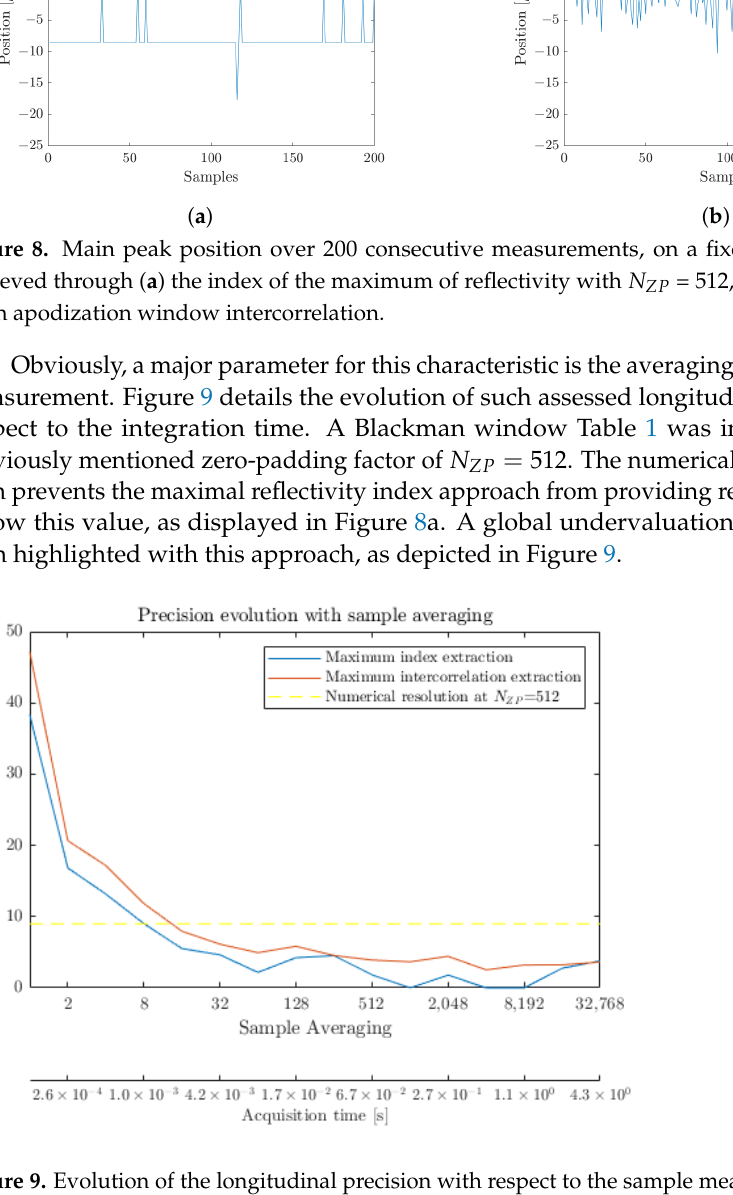
Figure 9. Evolution of the longitudinal precision with respect to the sample measurement